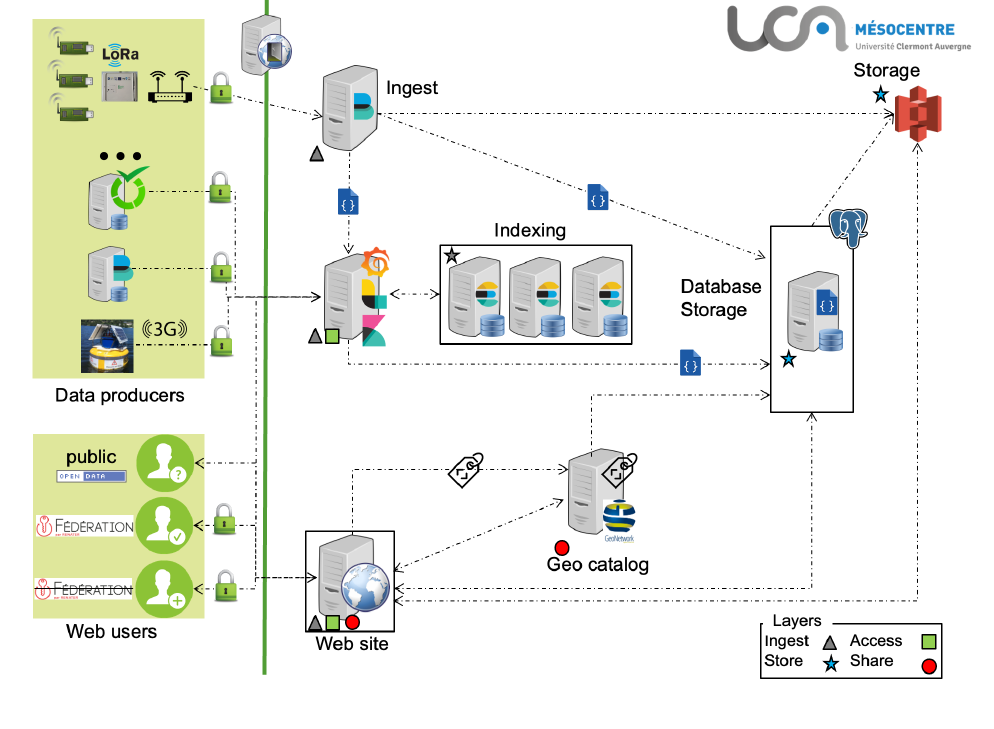
Figure 2. Global architecture of